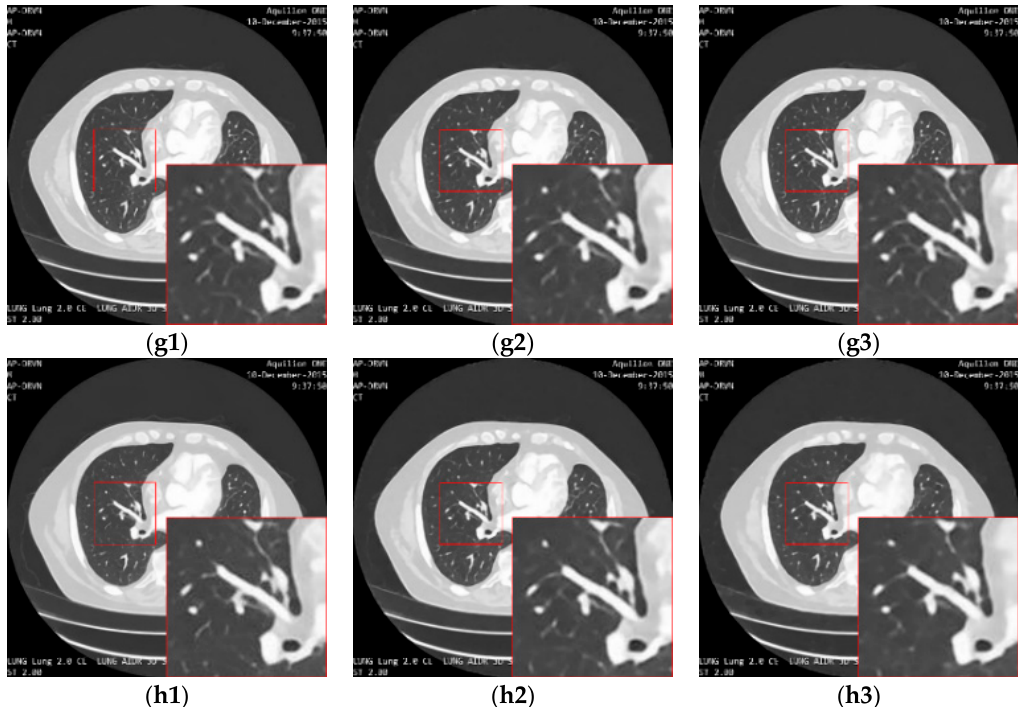
Figure 14. The result of enhancement of the quality of images corrupted by noise with di ff erent levels and low-resolution through di ff erent methods. ( a1 ), ( a2 ) and ( a3 ) are the input images with noise level 5, 10 and 15. ( b1 ), ( b2 ) and ( b3 ) are the ground truth image. ( c1 ), ( c2 ) and ( c3 ) are the images ( a1 ), ( a2 ) and ( a3 ) processed by the bicubic method. ( d1 ), ( d2 ) and ( d3 ) are the images ( a1 ), ( a2 ) and ( a3 ) processed by the SRMD method. ( e1 ), ( e2 ) and ( e3 ) are the images ( a1 ), ( a2 ) and ( a3 ) processed by the SRCGAN method. ( f1 ), ( f2 ) and ( f3 ) are the images ( a1 ), ( a2 ) and ( a3 ) processed by the RED-CNN method. ( g1 ), ( g2 ) and ( g3 ) are the images ( a1 ), ( a2 ) and ( a3 ) processed by the RDN method. ( h1 ), ( h2 ) and ( h3 ) are the images ( a1 ), ( a2 ) and ( a3 ) processed by the proposed method.